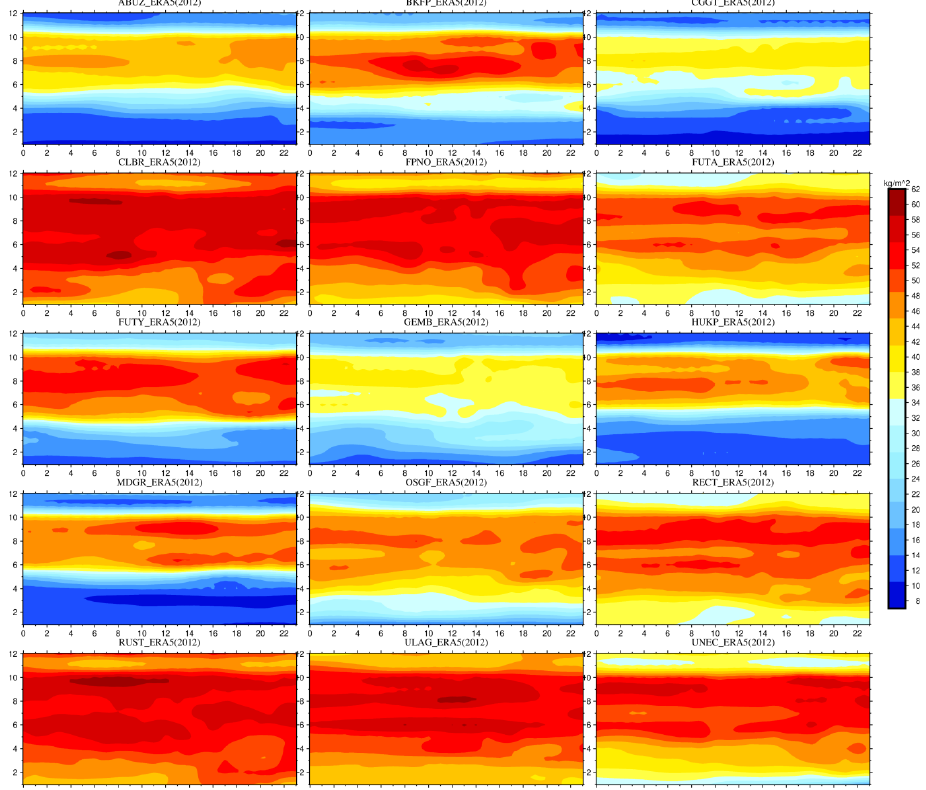
Figure 3. Sub-daily variation of ERA5 PWV (kg/m 2 ) over 15 CORS for year 2012, plots are months against time (UTC hours)